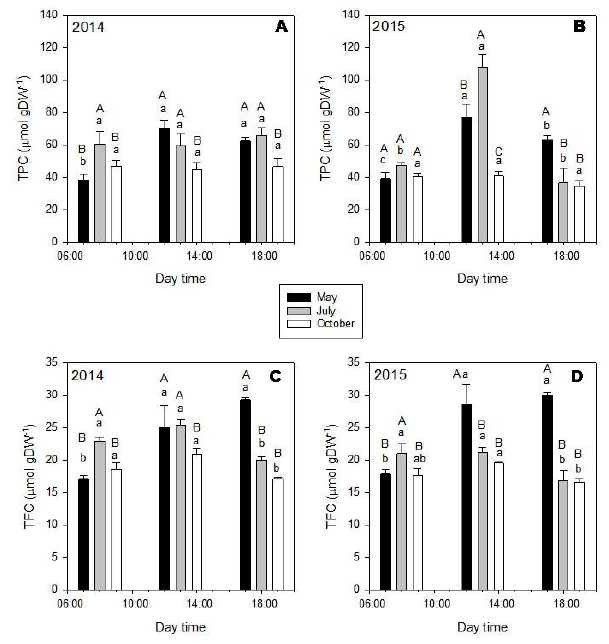
Figure 6. Total phenolic (TPC—upper graphics) and total flavonoid contents (TFC—down graphics) of Cistus incanus extracts of leaves harvested in 2014 (left) and 2015 (right), during the di ff erent months (May—black bars; July—grey bars; October—white bars) and day times (8:00; 13:00 and 18:00). In general, the highest values were obtained in May and July. Mean values ± SD in µ mol gDW − 1 ( n = 3). Data was analyzed by two-way ANOVA test, with Tukey post-test, after variance homogeneity analysis by test and normality analysis by Shapiro–Wilk test. Equal capital letters indicate no statistical di ff erences between the monthly results (at the same time) and lowercase letters indicate no statistical di ff erences between daily results (inside the same month) ( p ≤